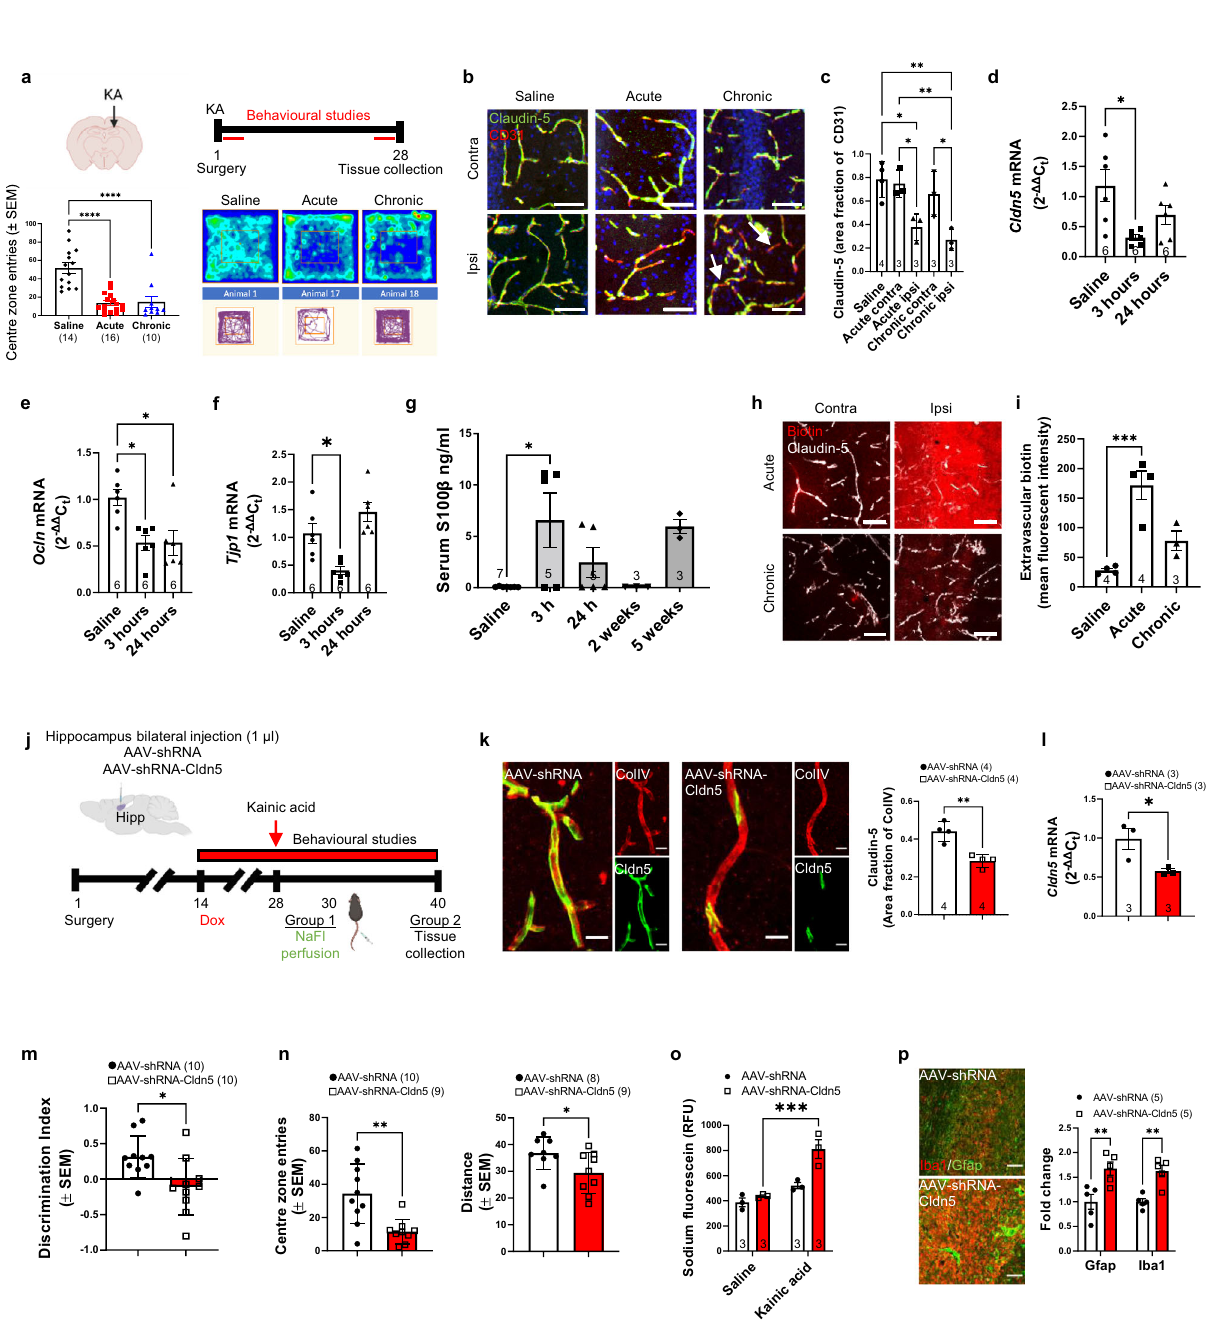
Fig. 1 Drug resistant temporal lobe epilepsy induces blood-brain barrier leakage and Cldn5 downregulation in the hippocampus. a Representative dynamic contrast-enhanced MRI (DCE-MRI) images from 4 patients with temporal lobe epilepsy (TLE, top panel). Colour bar represents slope of contrast agent. b T2 weighted images (middle panel) and ( c ) fl uid attenuated inversion recovery (FLAIR) images (bottom panel). d Claudin-5 (CLDN5; green) and CD31 (red) staining in non-diseased autopsy control (CNTRL) and TLE cases. Scale bars, 20 μ m. e Collagen-IV (ColIV; green) and IgG (red) staining in CNTRL and TLE cases. Scale bars, 50 μ m. f Levels of CLDN5 were signi fi cantly decreased (** p = 0.0042) and g IgG was signi fi cantly increased (**** p < 0.0001) in the brains of TLE cases vs CNTRL. Data represent means± s.e.m.; each datapoint represents one patient. Number of subjects ( n ) is indicated on graphs. Two-sided Mann – Whitney test for immunohistochemical and western blot analysis. ** p < 0.01; **** p < 0.0001. Source data are provided as a Source Data fi le.